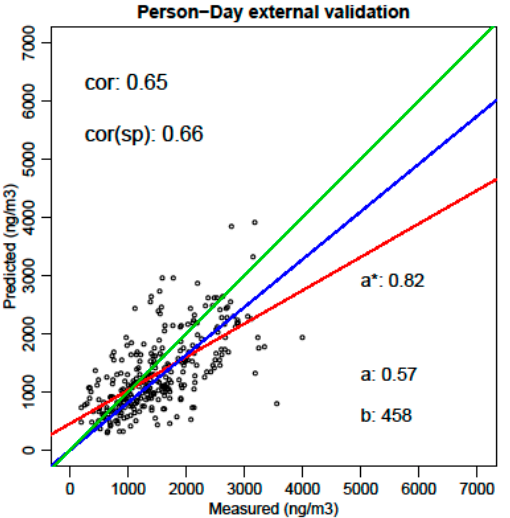
Figure 7. External validation (prediction versus measurements) of the personal daily instantaneous exposure for Black Carbon including in-traffic exposure using the µLUR methodology (293 person-days). Regression lines forced through zero (blue) and free regression (red) are compared to the ideal case (green).